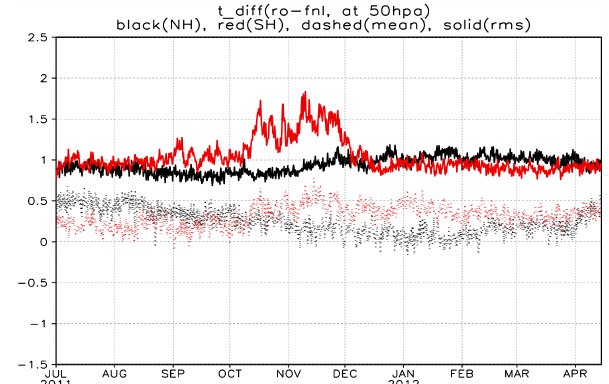
Figure 7. Anomaly correlation coefficient (ACC) for the 500mb height for the 8-day forecast. The solid line denotes the full ob- servations experiment, and the dashed line denotes the experiment without RO observation. The black lines denote the Northern Hemi- sphere, the red lines denote the Southern Hemisphere. Experiment period is same to that of Fig. 6; it is from 31 samples.